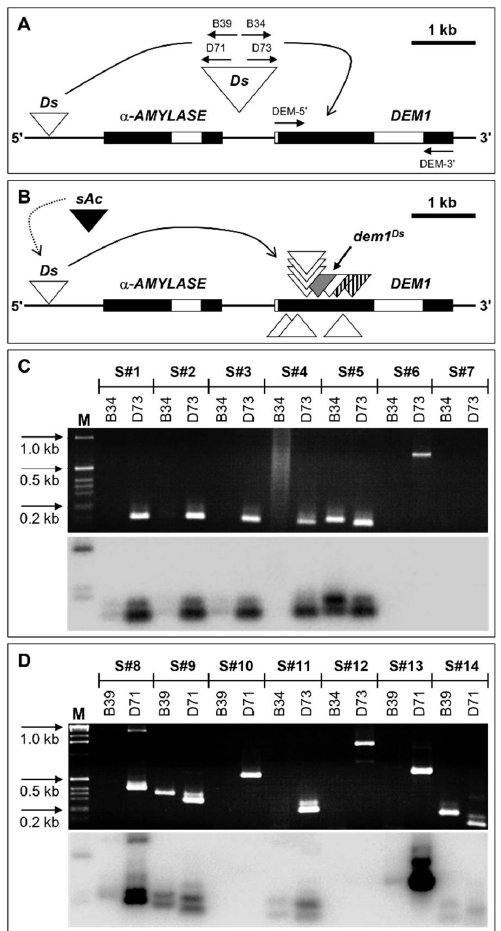
Figure 3. PCR-based identification of independent Ds insertion events into the SlDEM1 locus in individual dem1 mutant sectors of mature SMD leaves. ( A ) Schematic of the location of primers used, including the DEM1- specific primers, DEM5’ and DEM3’, and the Ds- specific primers B34, B39, D71 and D73, to detect independent Ds insertion events into the SlDEM1 locus in individual dem1 mutant sectors of SMD leaves. The a-AMYLASE gene situated between the mapped Ds launching pad and the DEM1 locus in the SMD transformant line is also depicted with black boxes representing exons and white boxes representing introns of the - AMYLASE and DEM1 genes. ( B ) Schematic of the location (as determined by the size of individual PCR products) of individual Ds insertions mapped to the SlDEM1 locus of dem1 mutant sectors sampled from the leaves of the SMD transformant line with white triangles above the line representing Ds insertions into the forward strand of SlDEM1 and white triangles below the line representing Ds insertions into the reverse strand of SlDEM1 . The exact position of two Ds insertions into the DEM1 locus was verified by sequencing of cloned PCR products as represented by triangles with vertical lines. The grey shaded triangle represents the position of a mapped Ds element into the DEM1 gene (termed the dem Ds insertion) which was in- cluded in this analysis as a positive control for Ds insertion into SlDEM1 . ( C ) For samples S#1 to S#7, primer DEM5’ was used together with primers B34 (primary PCR) and D73 (semi-nested PCR) for amplicon production. ( D ) The DEM5’ primer was also used for PCR product amplification from samples S#8 to S#10 together with primers B39 (primary PCR) and D71 (semi-nested PCR). The pri- mer, DEM3’, together with primers B34 (primary PCR) and D73 (semi-nested PCR), were used for amplicon generation from samples, S#11 and S#12, and for samples S#13 and S#14, the DEM3’ pri- mer was used together with the B39 (primary PCR) and D71 (semi-nested PCR) primers to generate PCR amplicons. In ( C , D ) the upper panel is a photograph of an ethidium bromide-stained agarose gel under UV-light, while the lower panel represents a Southern blotted membrane post hybridiza- tion with a SlDEM1 -specific probe.